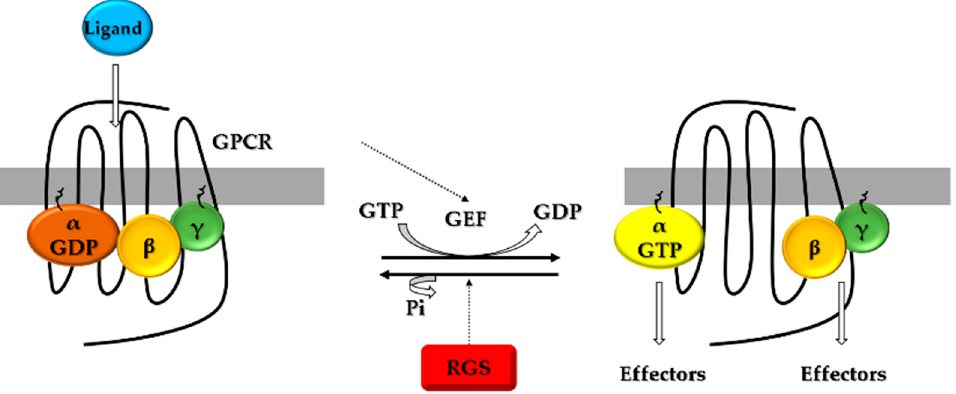
Figure 1. A standard model of the guanine nucleotide loop of receptor-mediated heterotrimeric G protein activation.